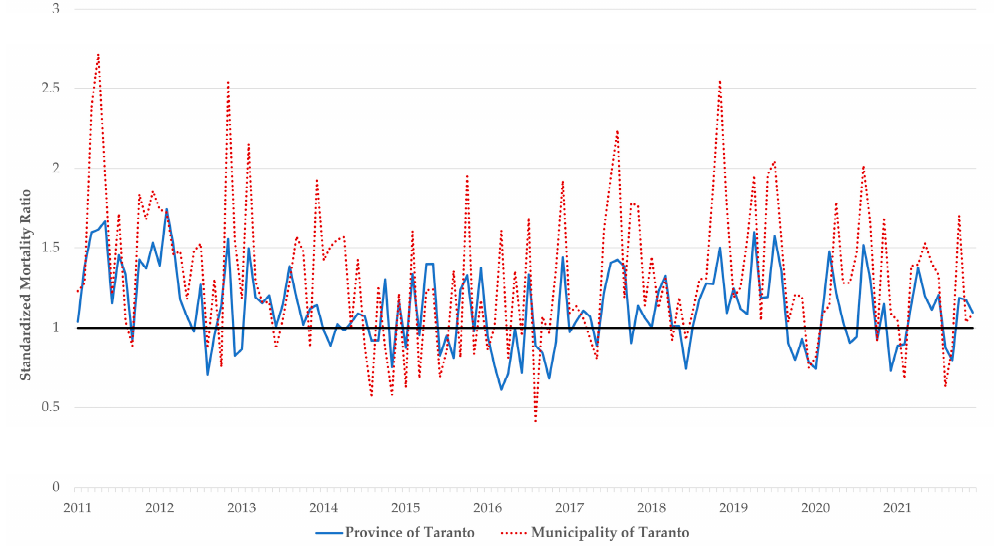
Figure 1. Time series of standardized mortality ratios for the province and the municipality of Taranto in the period 2011–2021. Table 3. Measures of goodness of fit of forecasting models applied to the series of adjusted mortal- ity